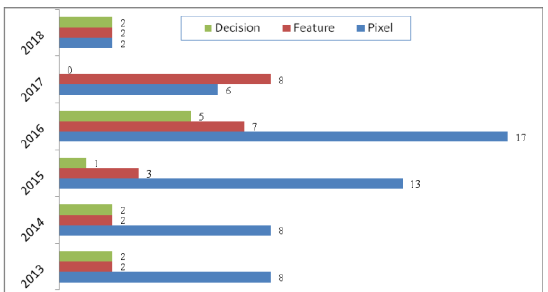
Figure 5: The numbers of studies with each level from 2013 to 2018